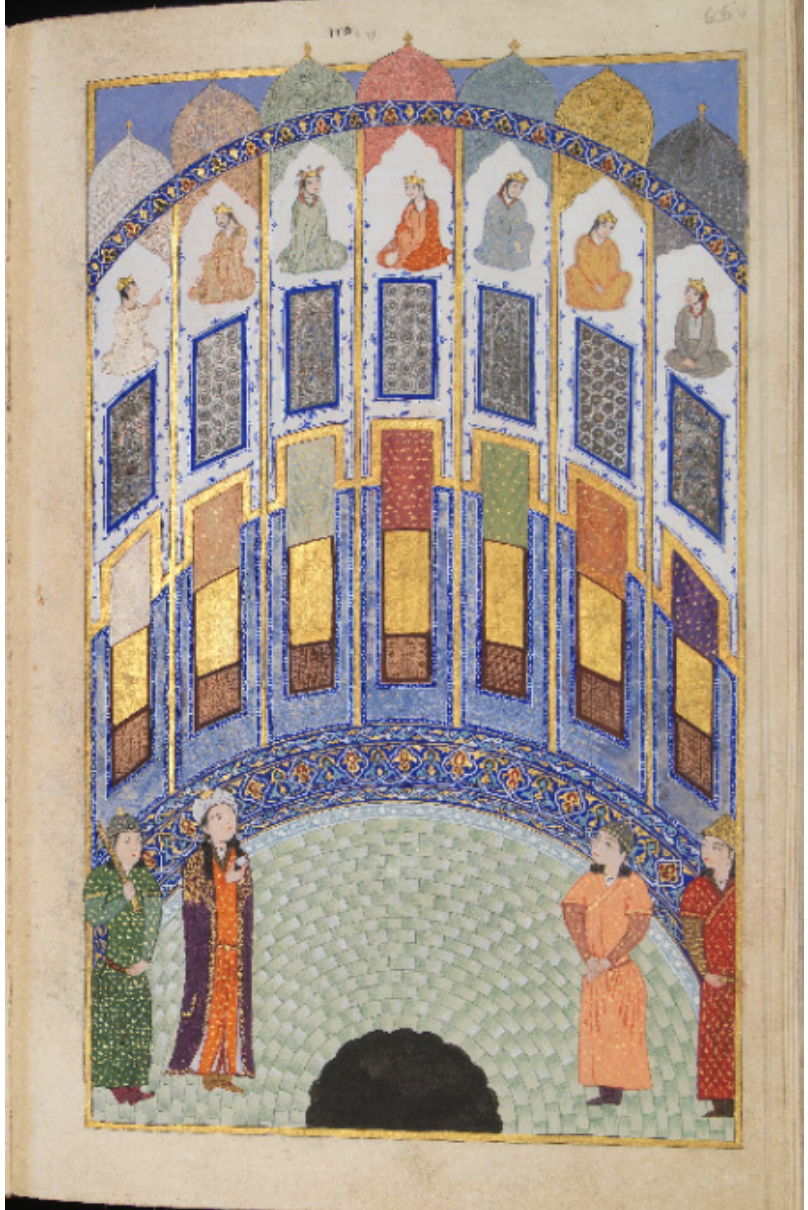
Figure 1. Miniature from the Anthology of Sultan Iskandar, Shiraz, Persia, Timurid period, 1410–11. © Calouste Gulbenkian Foundation. 2022.